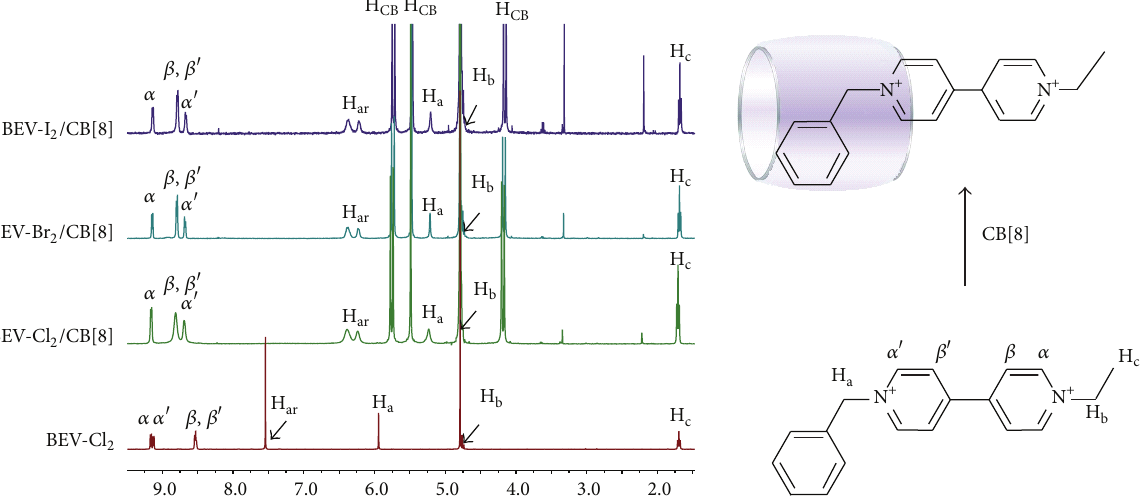
Figure 2: From bottom to up, 1 H NMR spectra for BEV-Cl 2 alone, 1: 1 including complexes of BEV-Cl 2 /CB [8] , BEV-Br 2 /CB [8] and BEV- I 2 /CB [8] , respectively, and the schematic representation of the assembly of BEV 2+ /CB [8] .